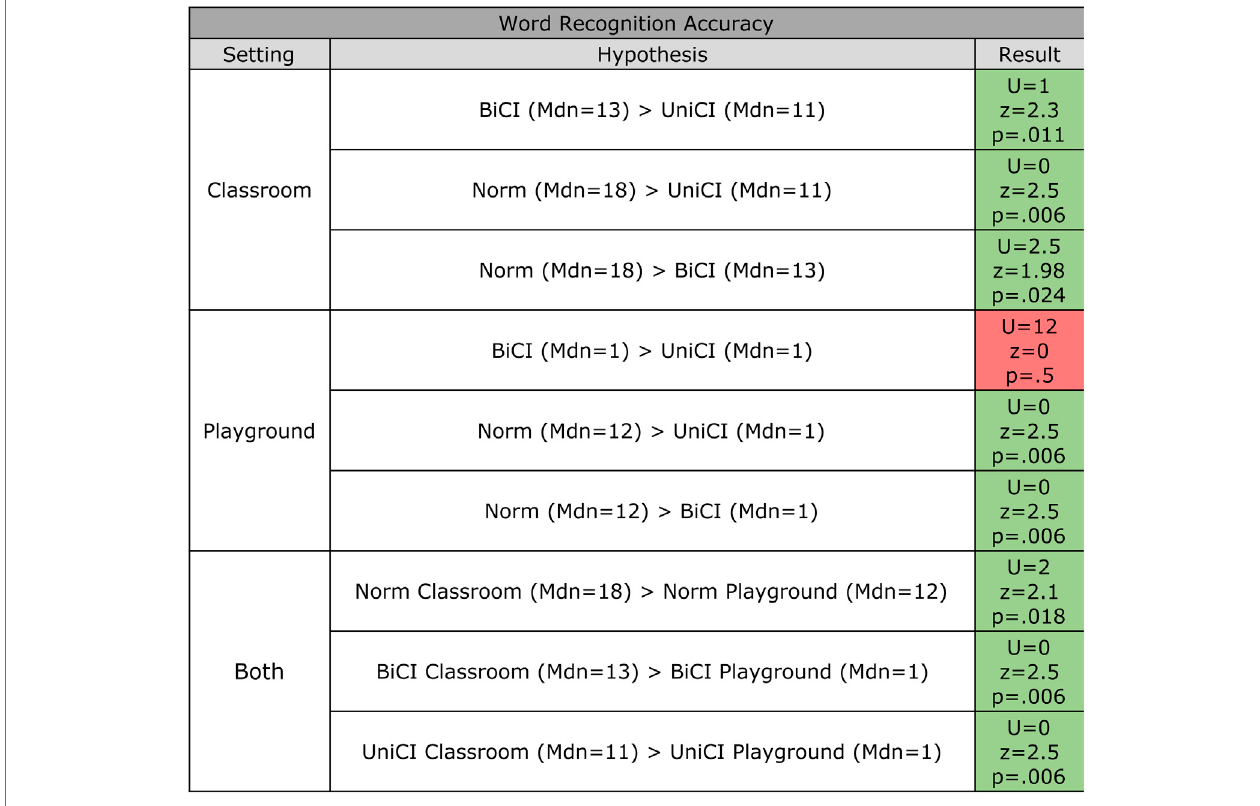
Frontiers in Virtual Reality |